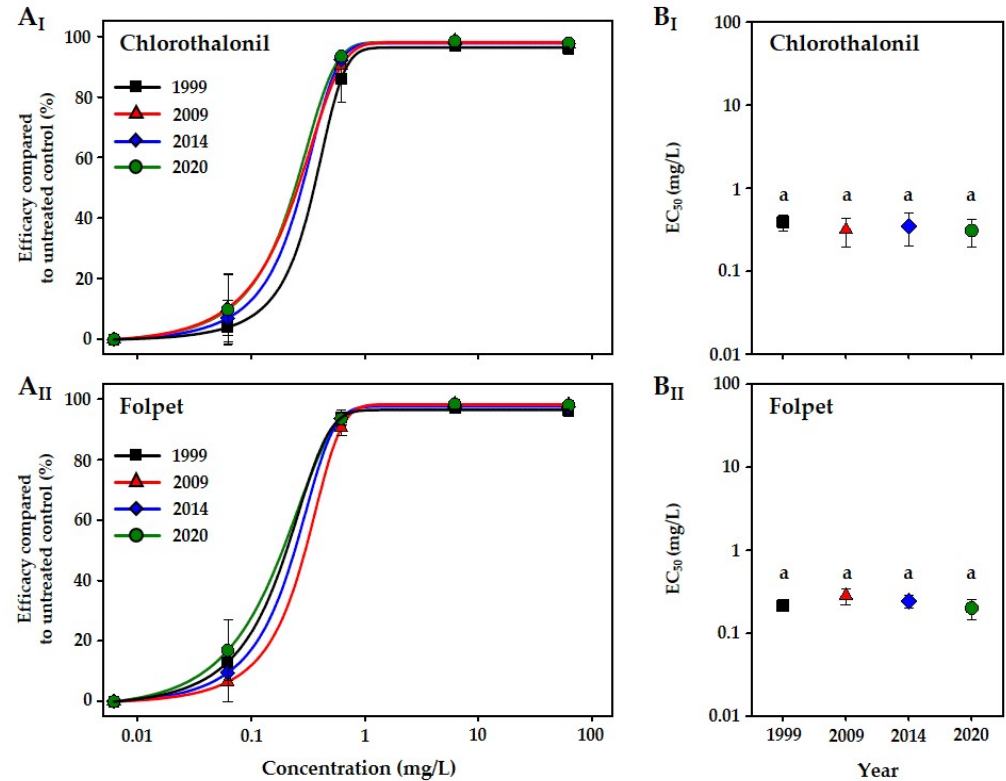
Figure 1. Changes in fungicide sensitivity of Zymoseptoria tritici field populations isolated in Northern Germany from two locations between 1999 and 2020 (isolation years 1999, 2009, 2014, 2020) to the multi-site inhibitors chlorothalonil ( A I , B I ) and folpet ( A II , B II ) using microtiter assays. ( A I , A II ) Relationship between fungicide concentration and fungicide efficacy. Efficacy data (mean ± SD) of the several fungicide concentrations are expressed as a percentage reduction of fungal growth compared to the untreated control. Means ( ± SD) were calculated for each year of Z. tritici isolation and each concentration including both locations and three replications per location. ( B I , B II ) Comparison of EC 50 values (mg/L). EC 50 values (mean ± SD) were determined as the fungicide concentration reducing fungal growth by 50%. Means ( ± SD) were calculated from EC 50 values of both locations and three replications per location. Different letters describe significant differences in EC 50 values between years. Statistical significance was evaluated at p ≤ 0.05.